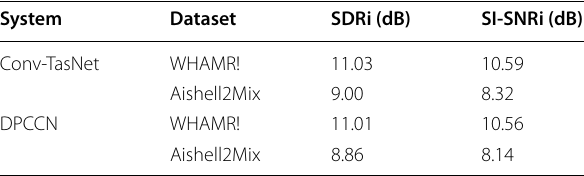
Table 3 Performance of Conv-TasNet and DPCCN trained with